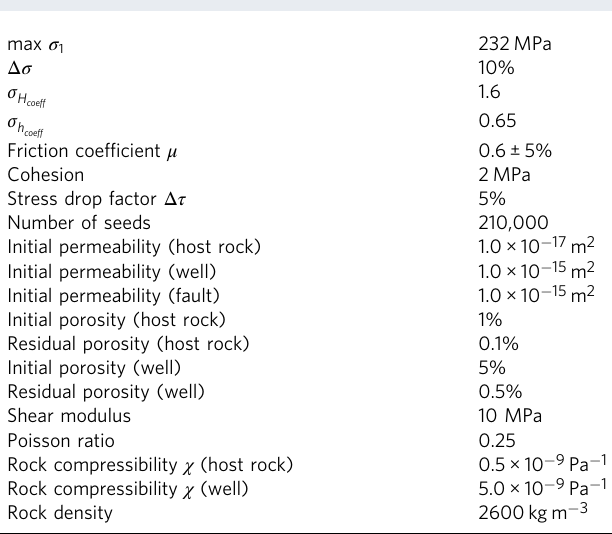
Table 2 Hydraulic and physical parameters used in the TOUGH2-Seed